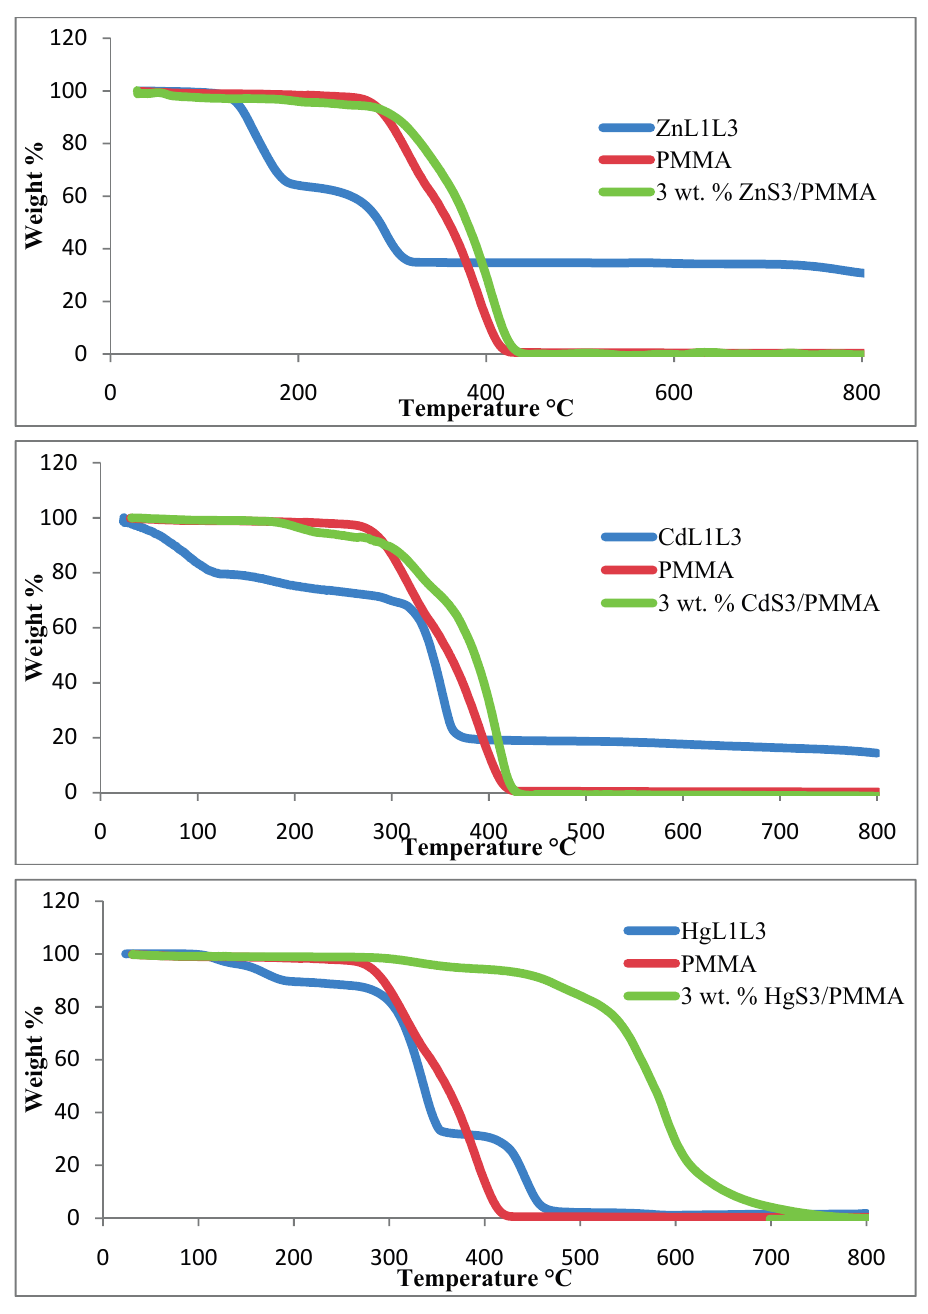
Figure 3. TGA curves for precursor complexes, pure PMMA and their corresponding metal sulfides/PMMA